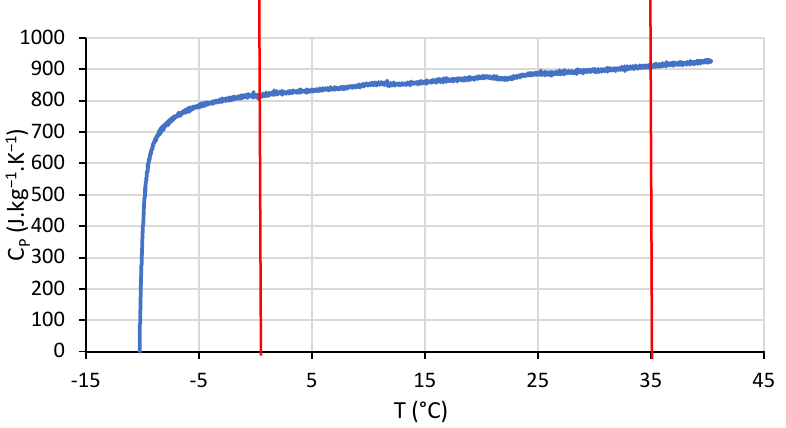
Figure 8. Specific heat capacity cob as a function of temperature.